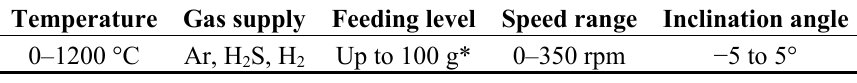
Table 1. Key parameters of the designed furnace.